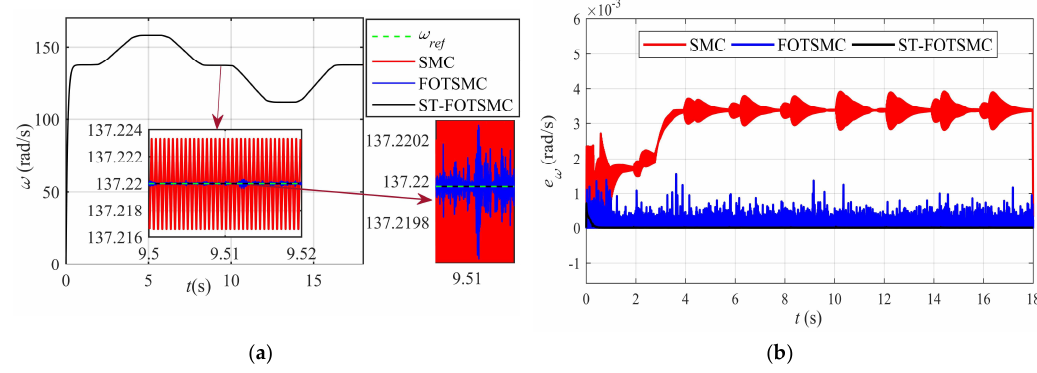
Figure 5. ( a ) Reference speed tracking comparison under normal conditions; ( b ) speed error comparison.